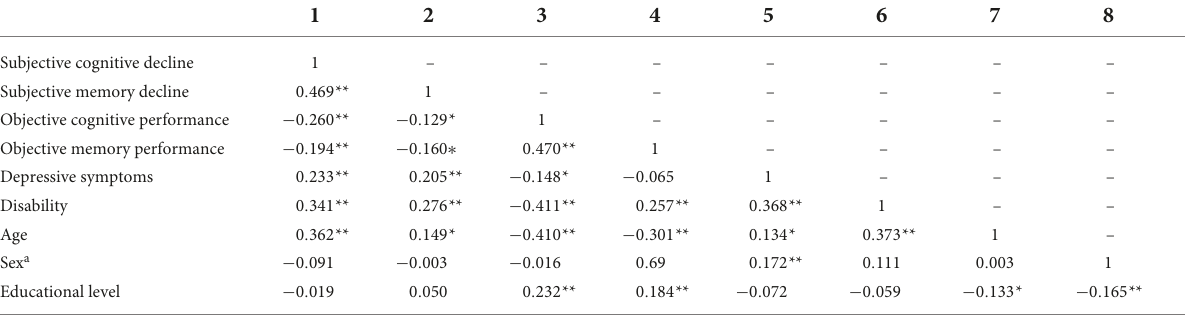
TABLE 2 Bivariate correlations of subjective cognitive and memory decline with objective cognitive and memory performance, depressive symptoms, disability, and participants’ age, sex, and educational levels.